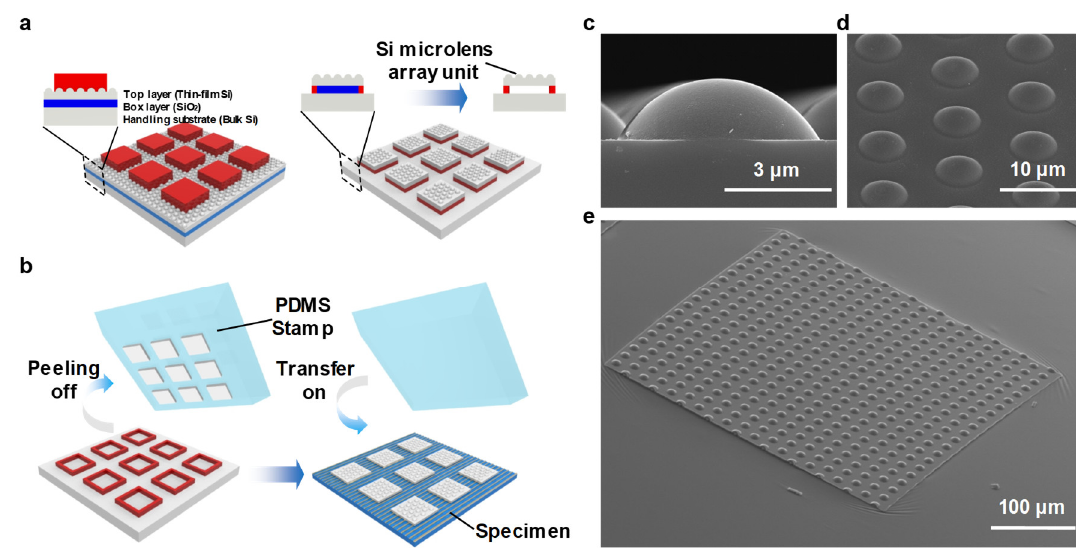
Figure 4. ( a ) Schematic illustration of the steps for fabricating printable silicon µ -SILs from a silicon on insulator (SOI) wafer and ( b ) subsequent transfer printing onto a specimen substrate. ( c ) Tilted-angle view of a scanning electron microscopy (SEM) image for a fabricated sample of printable silicon µ -SILs on rectangular silicon islands. ( d ) Magnified image of (c). ( e ) Cross-sectional view of a silicon µ -SIL unit. Table 1. Information of microlens arrays for infrared optical applications.